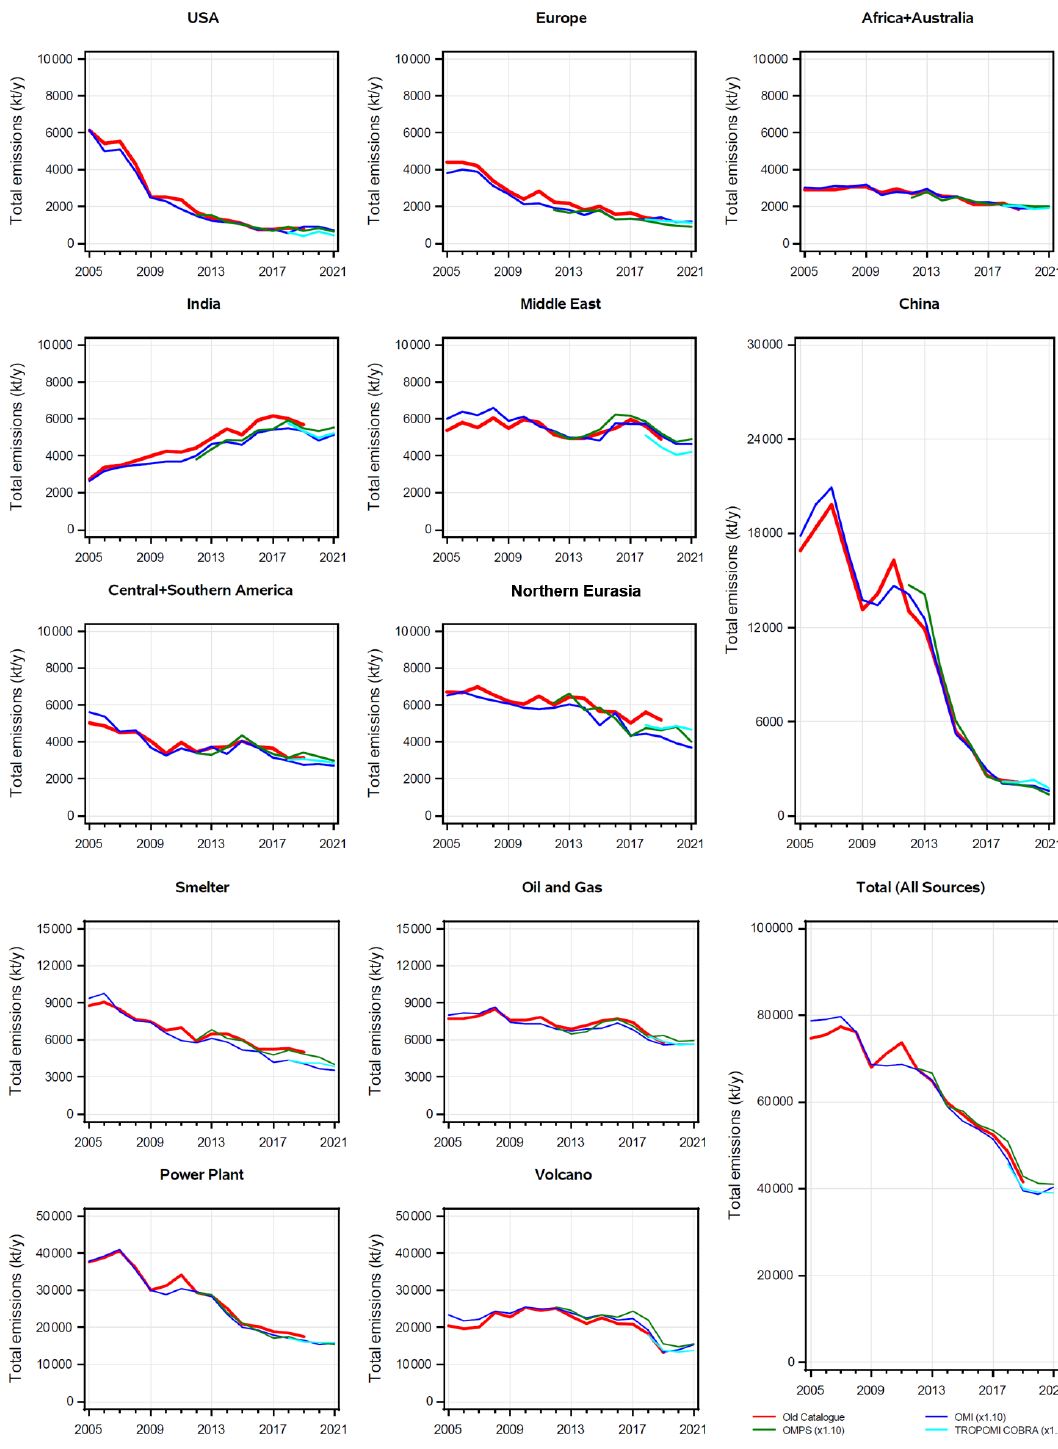
Figure 3. Annual SO 2 emissions estimated from four satellite datasets: the original catalogue (red), OMI-based estimates for the version 2 catalogue (blue), OMPS-based estimates for the version 2 catalogue (green), and TROPOMI COBRA-based estimates for the version 2 catalogue (cyan). The data are grouped by region (eight top panels), by emission source type (bottom four panels), and the bottom right panel shows total emissions from all sources. TROPOMI-based estimates are adjusted upwards by 22% to account for the difference in used SO 2 cross sections, and OMI and OMPS data are adjusted upwards by 10% as discussed in the text. Only sources included in the original catalogue with the original AMF values were used in this